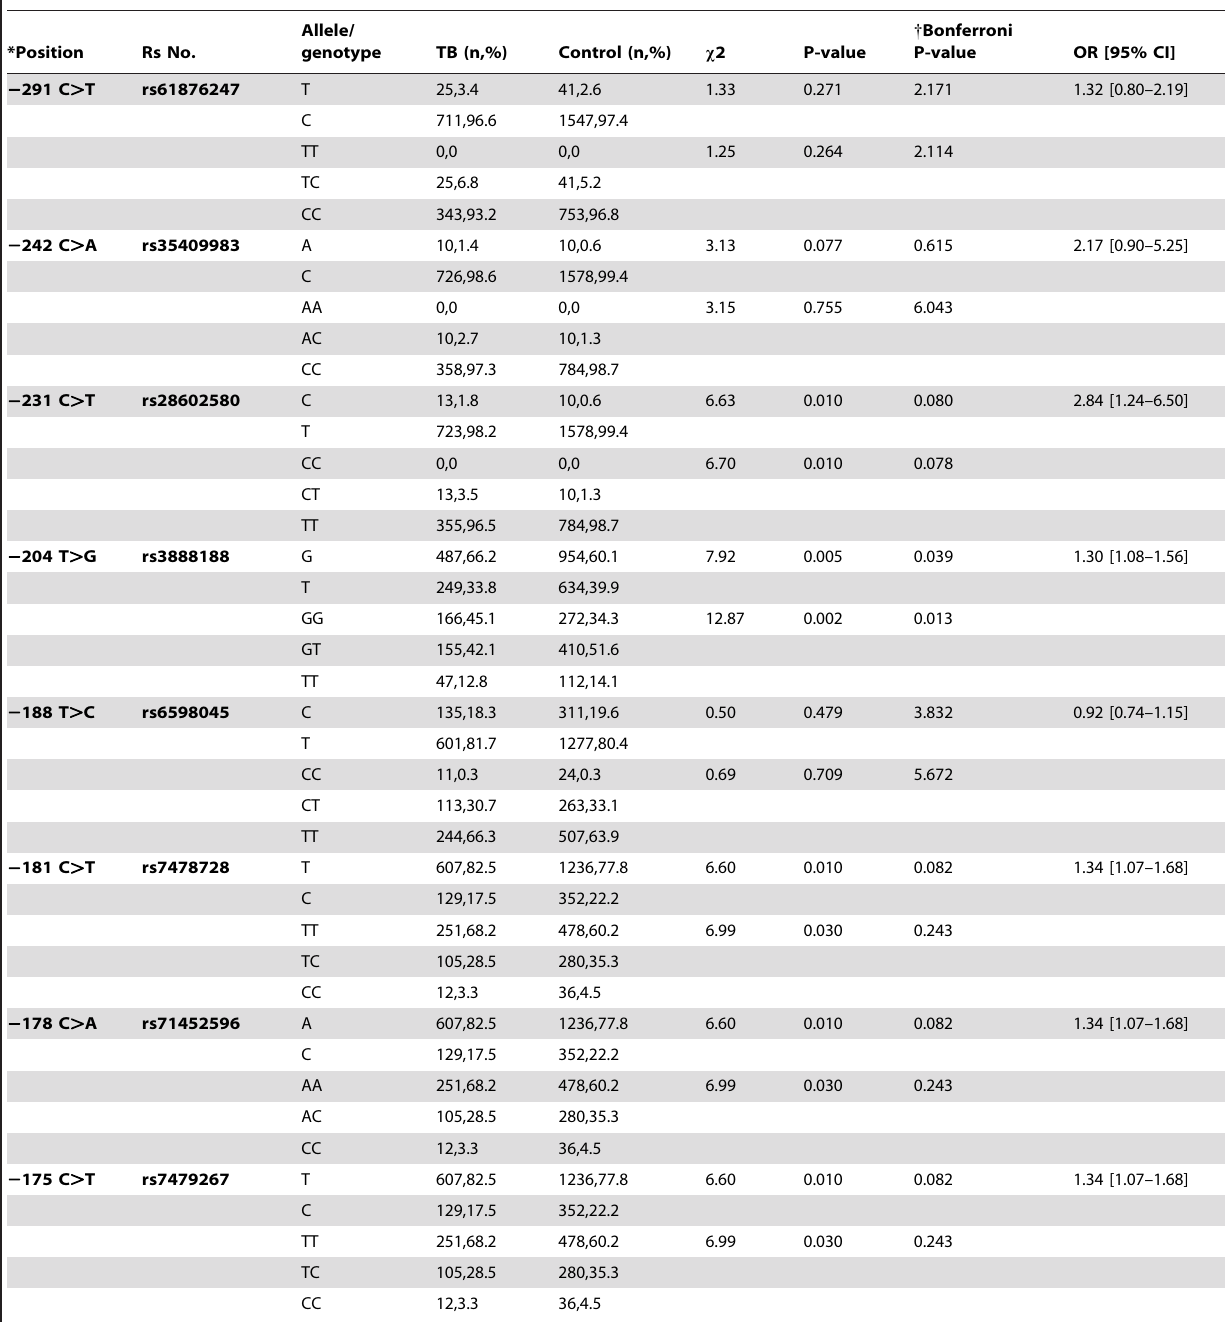
Table 2. The genotyping results of SNPs in IFITM3 core promoter.